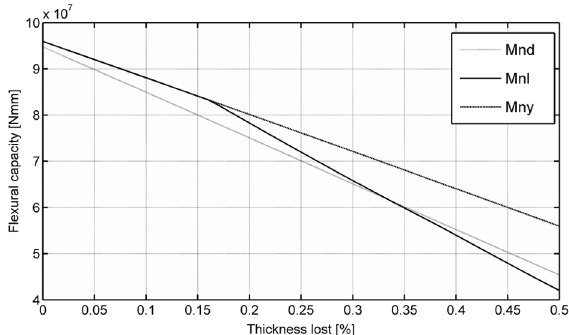
Fig. 4. The evolution of the moment at first yield, M y , the nomi- nal flexural strength for local buckling M nl and the nominal flexural strength, for distortional buckling M nd as a function of the dimensionless deterioration ξ ( t )